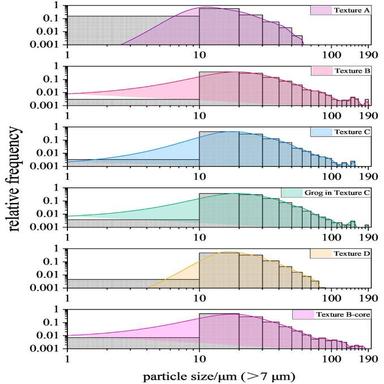
Histogram and particle size distribution curve of the four mould textures and one core texture. Note that a small proportion of particles were identified with a Feret diameter between 7 and 10 μm by the StarDist algorithm due to the irregular shape, though the particles with an area less than 78.5 μm2 were removed in the Despeckle operation of the CTan software.